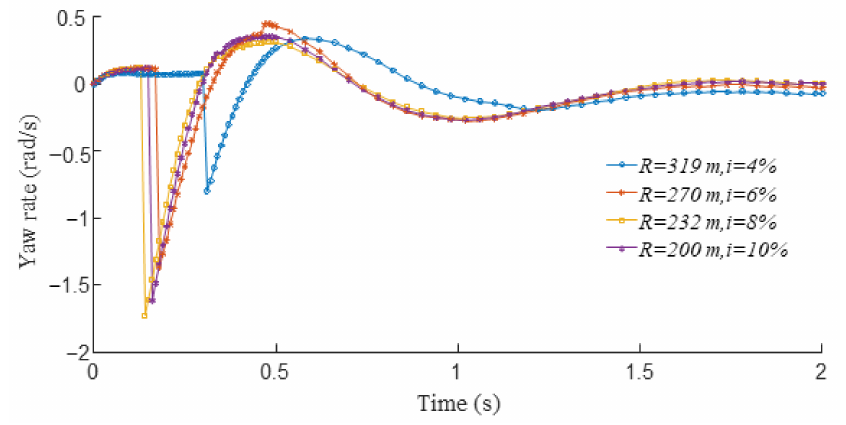
Figure 11. Simulation results of the yaw angular velocity at 80 km/h before